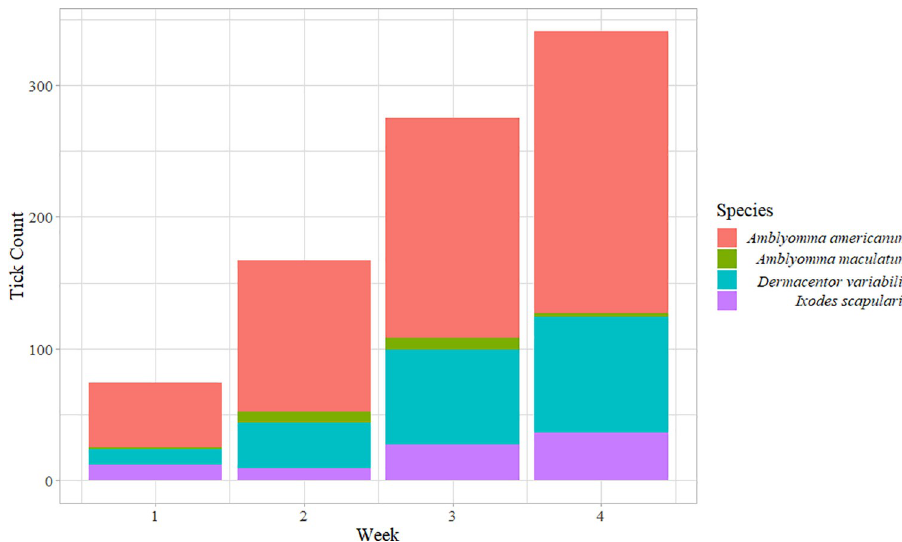
Fig 2. Ticks collected from the study region broken down by each week.